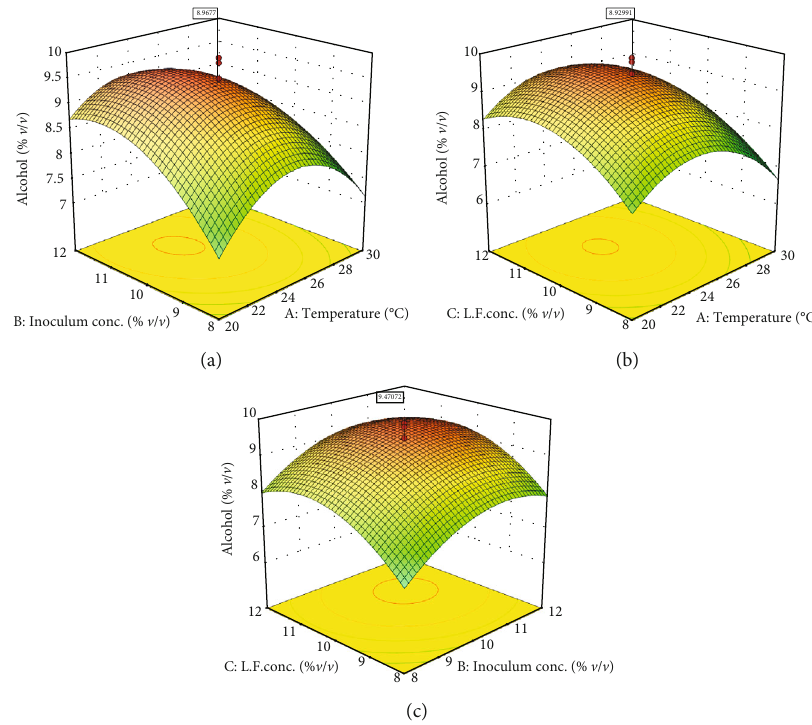
Figure 1: Response surface and contour plots for the e ff ect of inoculum concentration (a, Lantana camarafruit concentration = 10 %v / v ) and temperature; Lantana camara fruit concentration (b, inoculum concentration = 10 %v / v ) and temperature; Lantana camara fruit concentration (c, temperature = 25 ° C ) and inoculum concentration on the alcohol content of the produced wine.